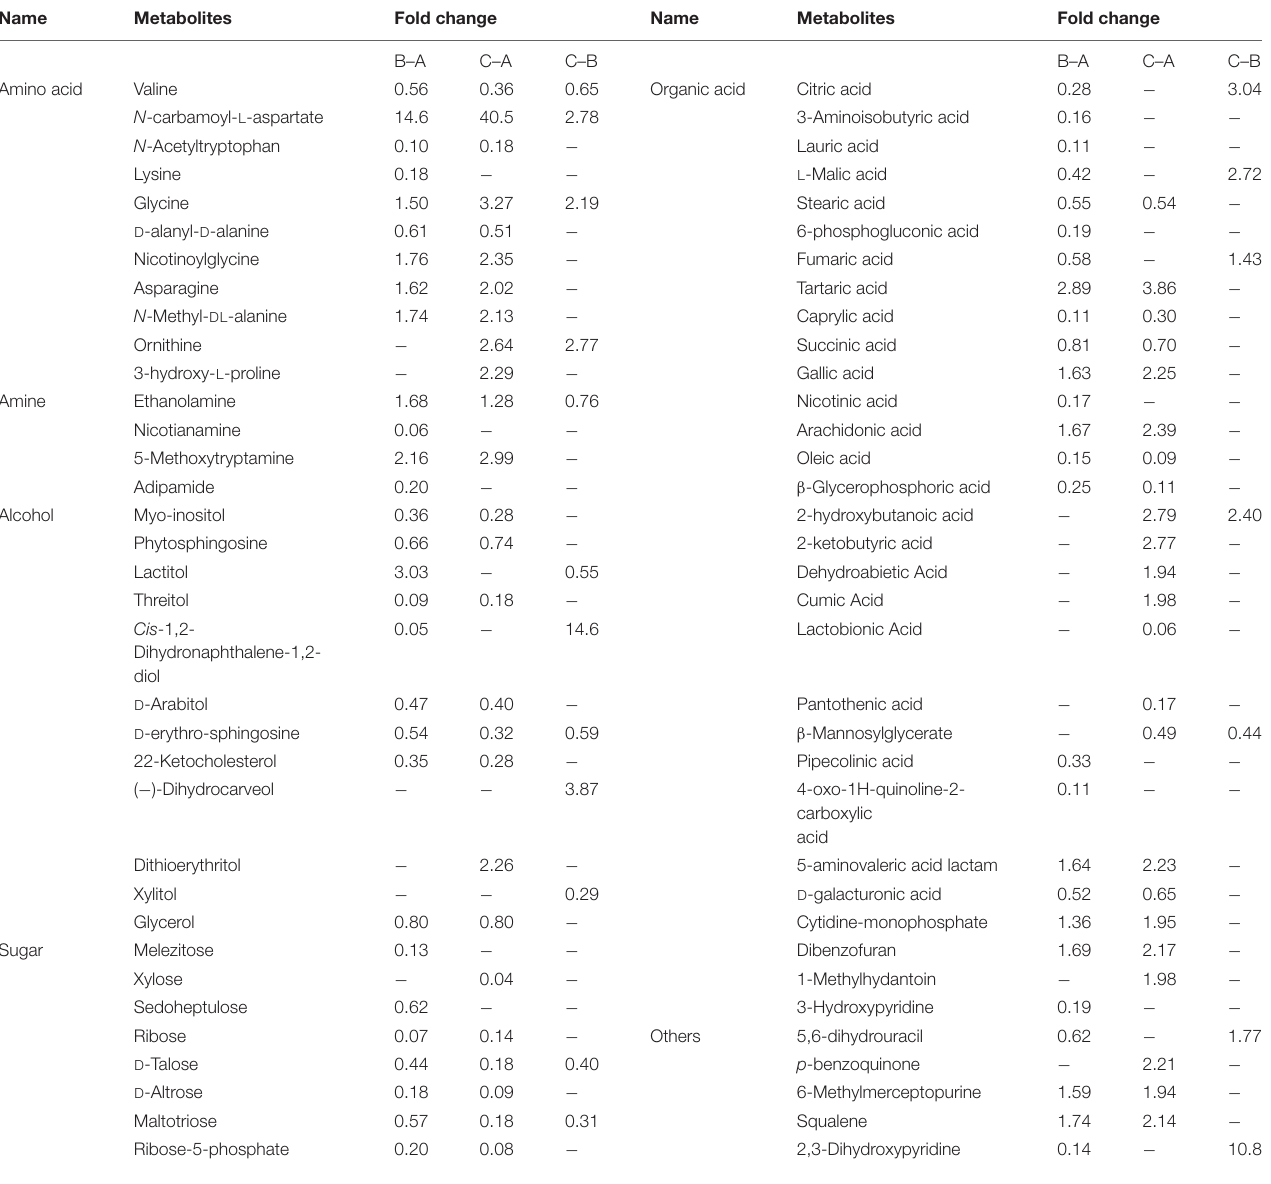
TABLE 4 | Differential metabolites among Mycelia A samples, Mycelia B samples, and Mycelia C samples identified by